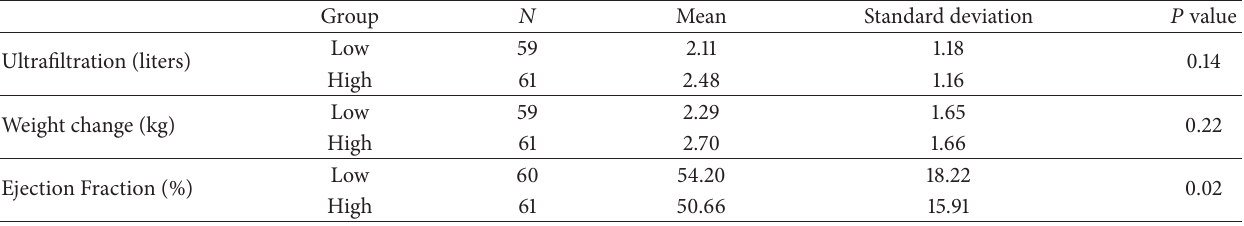
Table 3: Comparison of the high NT-ProBNP and low NT-ProBNP quartiles 1 using the Mann-Whitney U Test. Group 𝑁 Mean Standard deviation